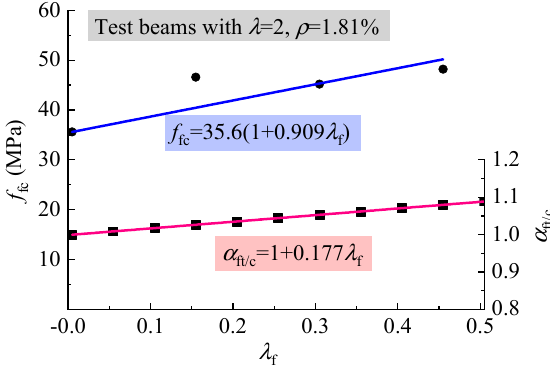
Figure 10. Variations of f fc and α ft/c with λ f .